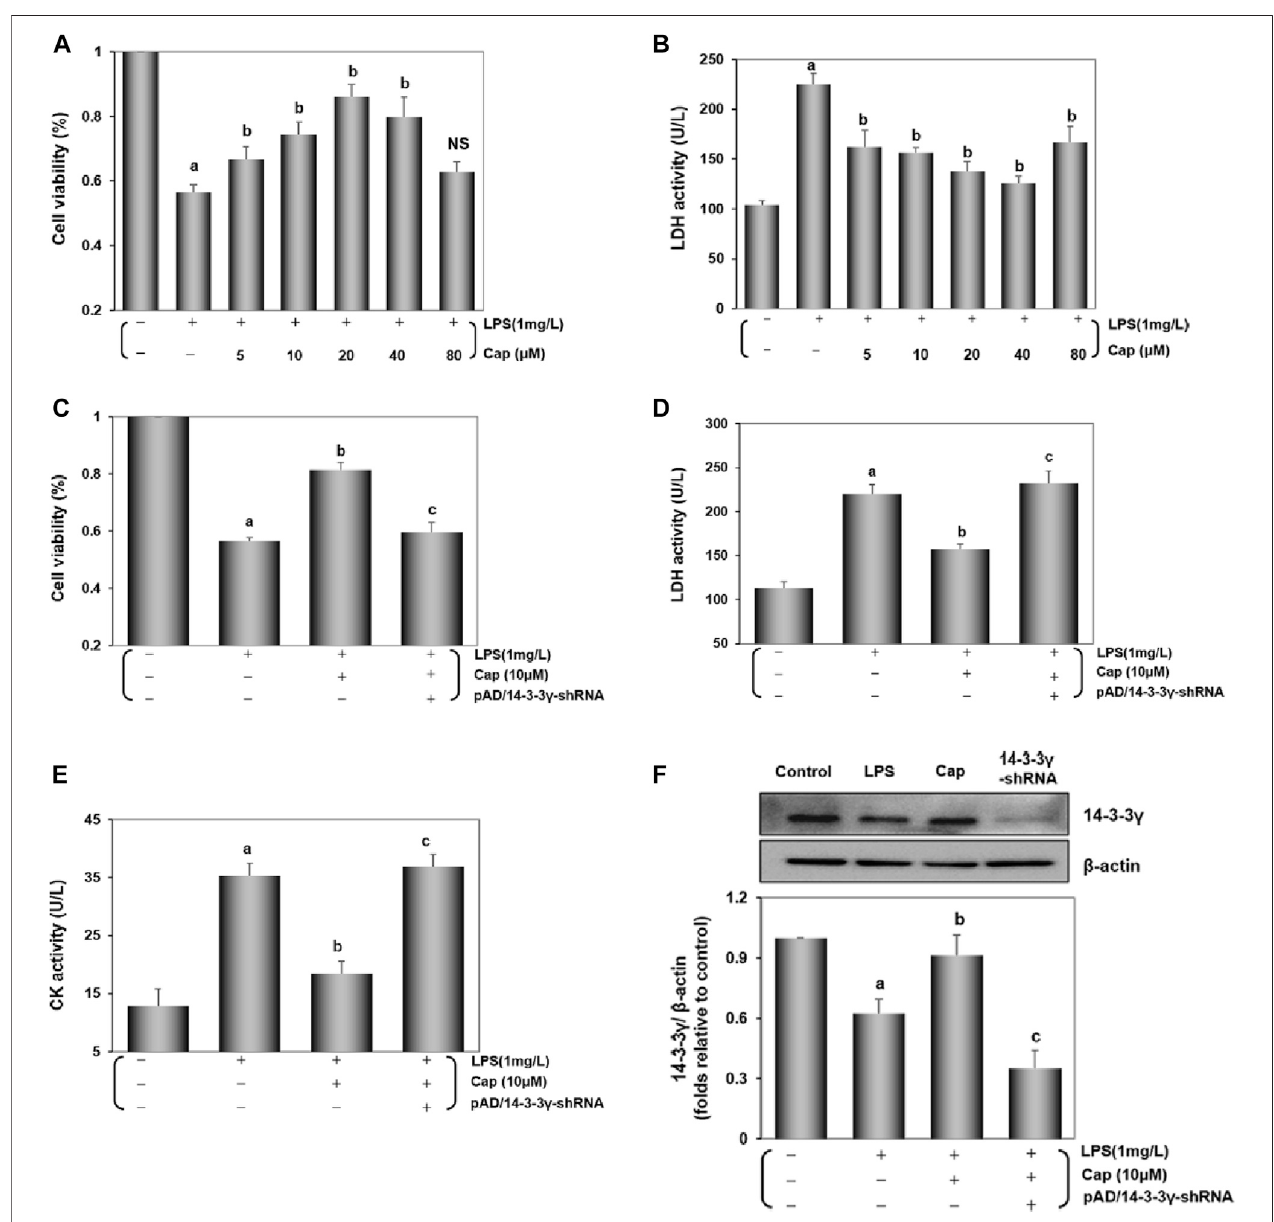
FIGURE1| Capprotects cardiomyocytesbyupregulating14-3-3 γ levels afterLPS challenge. (A) and (B) Cappresentedaconcentration-dependenteffecton cell viabilityandLDHactivityagainstLPS-induced cardiomyocyteinjury. (C) Capincreasedcellviability,andcotreatmentwithpAD/14-3-3 γ -shRNAnulli fi edCapeffectsafter LPS challenge. (D) and (E) LDH and CK activity in culture medium. (F) The representative western blot bands and the relative band intensity of 14-3-3 γ expression in cardiomyocytes.Valuesarepresentedasmean ± SEM.For fi veindividualexperiments,a: P < 0.01vs.thecontrolgroup;b: P < 0.01vs.theLPSgroup;c: P < 0.01vs. the Cap+LPS